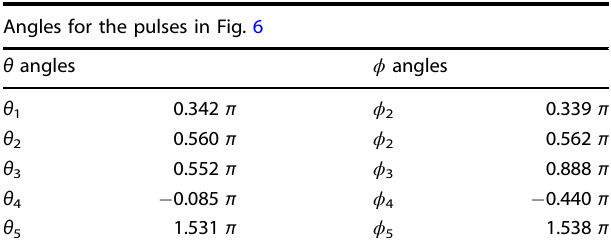
Table 1. Angles for the pulse sequence realizing the QEC for S = 5/2 as depicted in Fig. 6. Angles for the pulses in Fig.